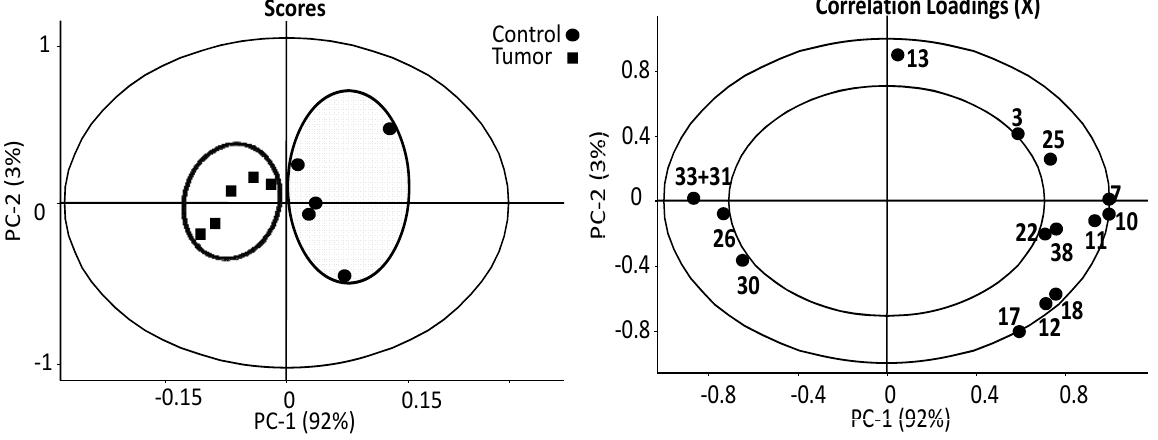
Figure 4. PCA analysis of the estimates of the absolute peak intensities from 1 H HR-MAS NMR using all the metabolites/metabolite peaks that can be extracted from the spectra. The tumor and the control are clearly separated from each other in PC-1 axial. The decreased estimates of absolute intensities in tumor group are peaks 3 (methyl), 7, 10, 11, 12 (methylene), 13 (choline), 17 (glycerol backbone), 22 (double bonds), 25 (lactate) and 38 ( β -glucose) with the correlation loadings in the positive PC-1. On the contrary, the negative PC-1 loading demonstrated that peaks 26 (alanine), 30 (glutamine) and 31 + 33 (creatine + glutathione) are elevated in the tumor group in estimates of absolute intensities. (number of samples in model) N = 10, (number of variables) K = 16, (number of latent components) A = 7, (model fit) R 2 = 0.96, (predictive ability) Q 2 = 0.95. The insider circle with radius r = 0.5, the outer one r =